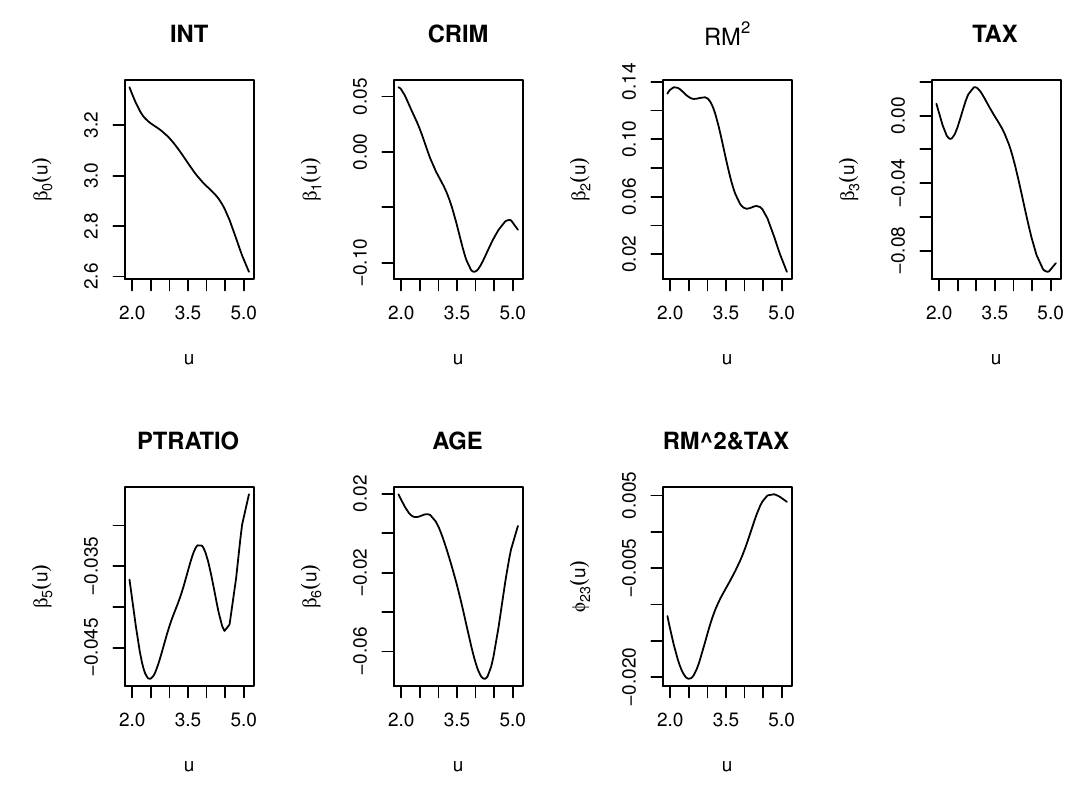
Figure 4. Estimated functional coefficients curves of the relevant